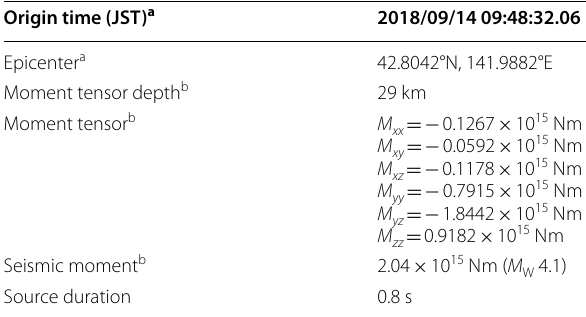
Table 2 Summary of source parameters in the aftershock waveform